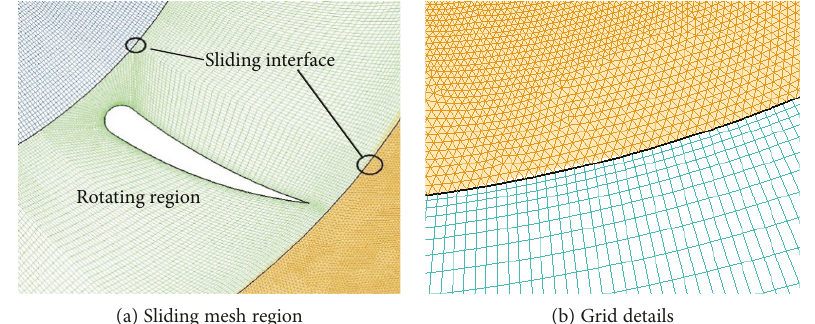
Figure 3: Interface and grid de fi nition.